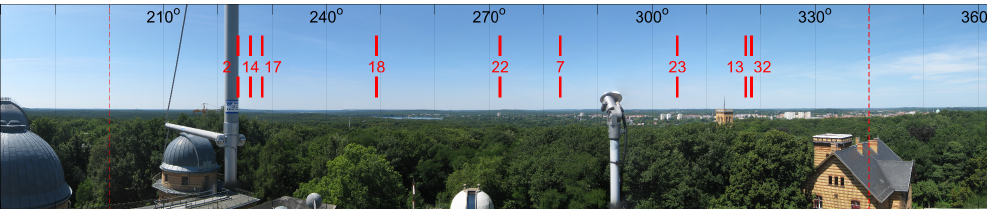
Figure 4. View towards west from the observation platform. The picture was taken about 2–3m behind the receiver’s GPS antenna, which is tilted by about 45 ◦ towards west (the antenna and its mounting pole is visible at about 290 ◦ azimuth angle). The metal structure at about 220 ◦ is part of a lightning protection system and does not block the antenna’s field of view, which ranges from 200 to 340 ◦ . Throughout the observation period a satellite with a given PRN sets beyond the horizon at almost the same azimuth angle. The angles of those nine PRNs discussed in the present study are marked in red.